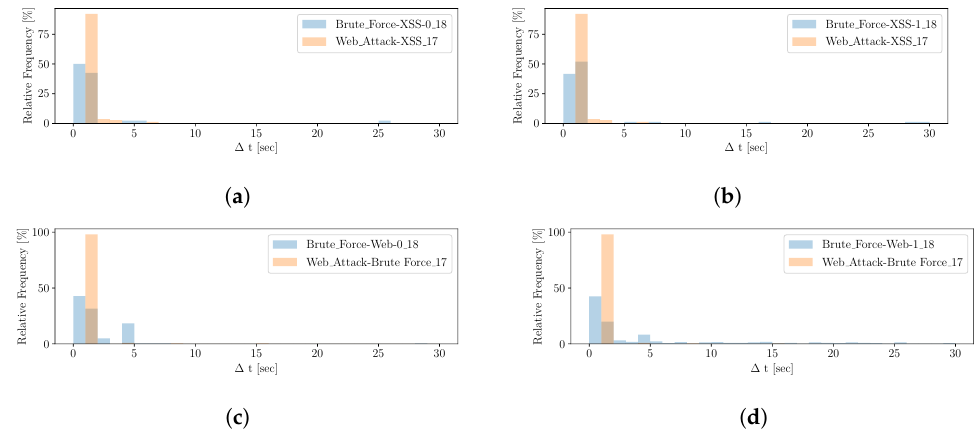
Figure 16. A comparison of ∆ t histograms of four distinct web attack scenarios— XSS ( a , b ) and Brute Force ( c , d )—present in CICIDS2017 and CSE-CIC-IDS2018. Table 8. The average processing time to generate sig temp for a selection of attack scenarios of CICIDS2017.